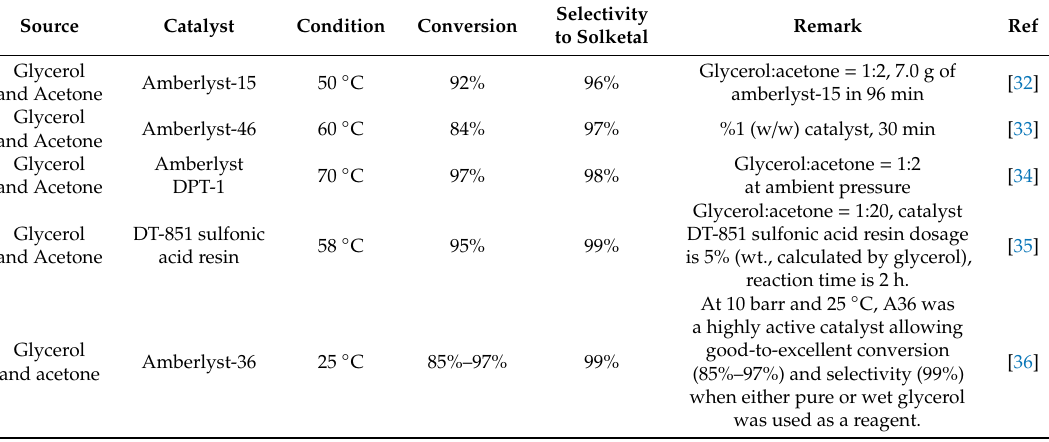
Table 3. Glycerol-to-solketal over resin